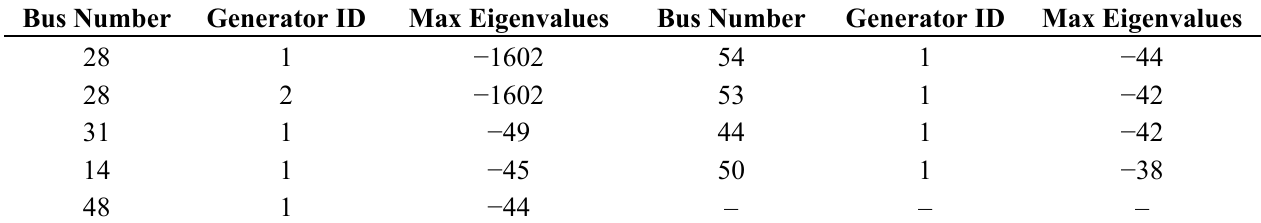
Table 3. Single machine infinite bus (SMIB) eigenvalue analysis with the GSO 37-bus case.